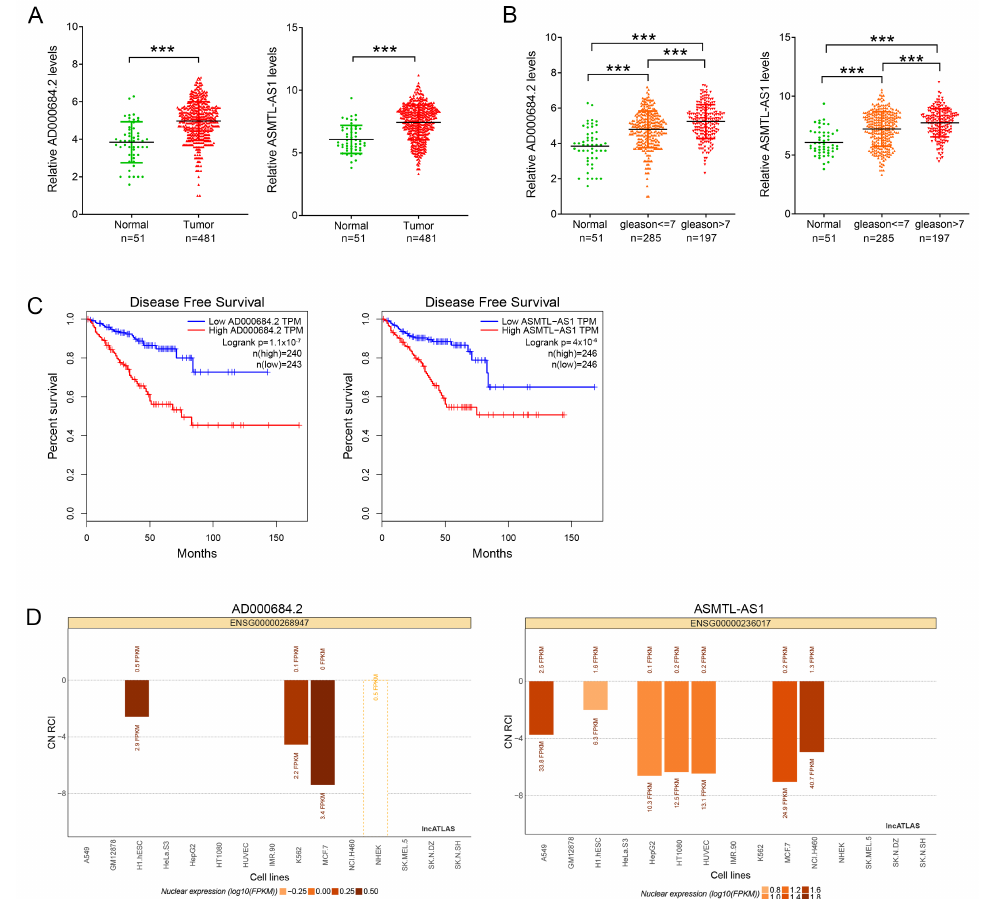
Figure 2. AD000684.2 and ASMTL-AS1 are highly expressed in PCa: ( A ) analysis of the expression Figure 2. Figure 2. levels of AD000684.2 and ASMTL-AS1 in PCa tissues and normal tissues acquired from the TCGA database (*** p < 0.001); ( B ) analysis of the relationship between the expression of AD000684.2 and ASMTL-AS1 and the pathological grade of PCa; ( C ) Kaplan–Meier curves for disease-free survival of PCa patients in a published dataset acquired from TCGA using the high quartile AD000684.2 or ASMTL-AS1 levels as the cutoff; ( D ) subcellular localization of AD000684.2 and ASMTL-AS1 in various cell lines obtained from the LncATLAS